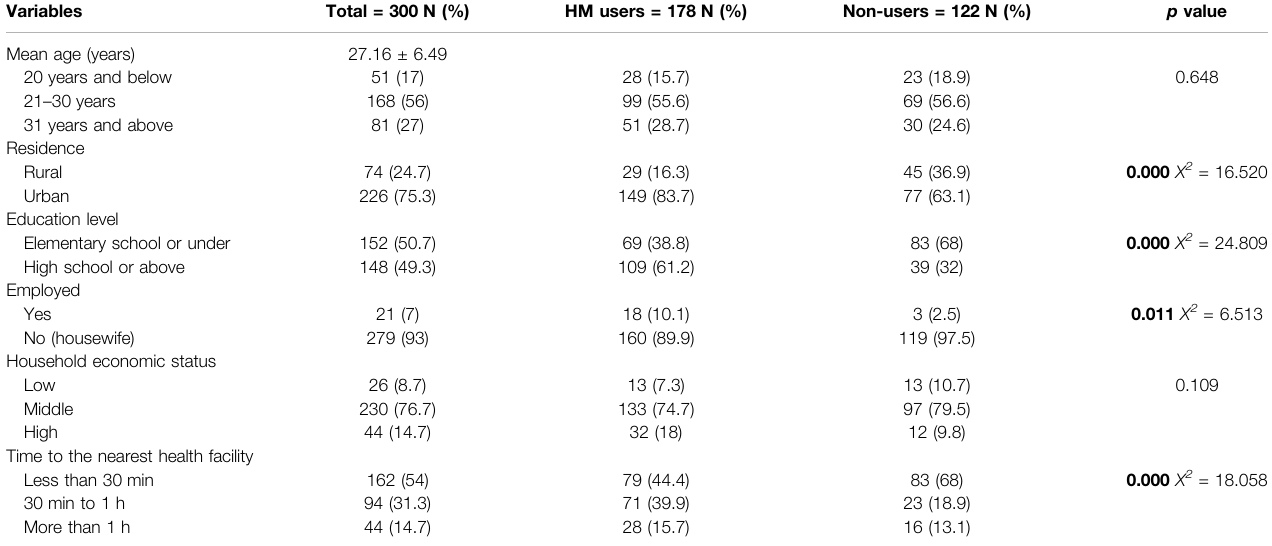
TABLE 1 | Sociodemographic characteristics of participants.